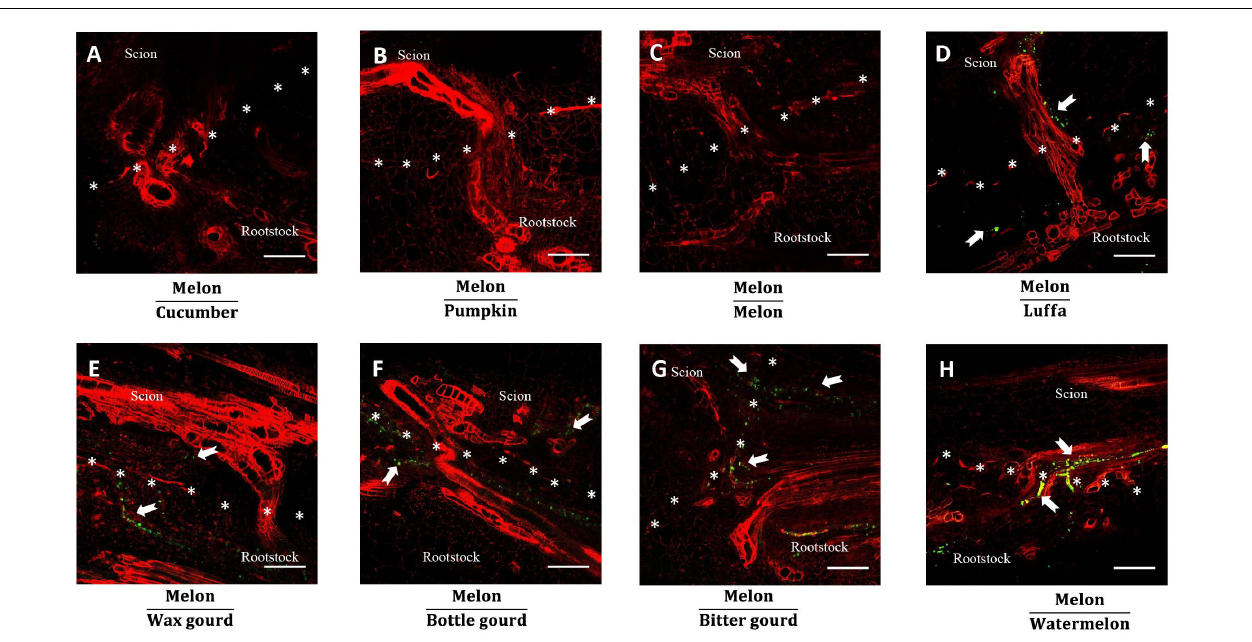
FIGURE 8 | Callose deposition of melon grafted onto eight Cucurbitaceae species. (A–H) Microscopic observation of the new vascular tissue at graft junction of melon cv. ‘Akekekouqi’ grafted onto cucumber cv. ‘Jinyou No.35,’ pumpkin cv. ‘Qingyouzhen No.1,’ melon cv. ‘Akekekouqi,’ luffa cv. ‘Sanbi No.6,’ wax gourd cv. ‘Aonong,’ bottle gourd cv. ‘H19,’ bitter gourd cv. ‘Liangku No.1,’ and watermelon cv. ‘Zaojia 8424’ on day 14 after grafting. Asterisks indicate graft junction. White arrows indicate callose deposition. Scale bar represents 200 µ